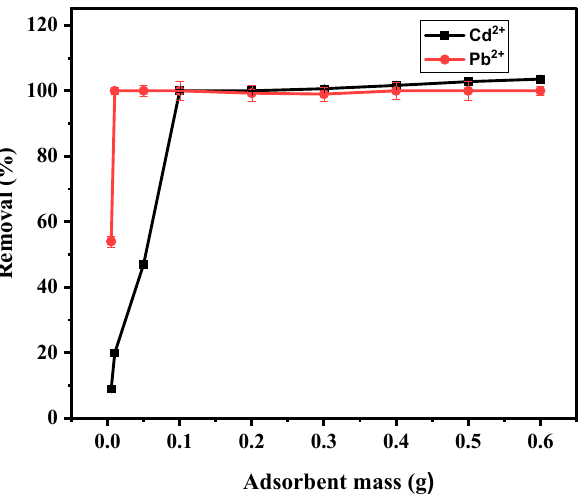
Figure 7. Effect of adsorbent mass on the adsorption of Cd 2+ and Pb 2+ using BPAC@Al 2 O 3 @chitosan material at a duration of 30 min, pH of 6, and initial concentration of 20 mg L − 1 .